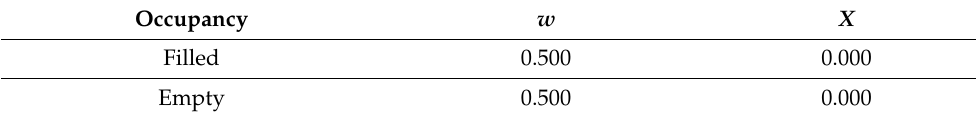
Table 10. Ranking of container occupancy according to retention time.